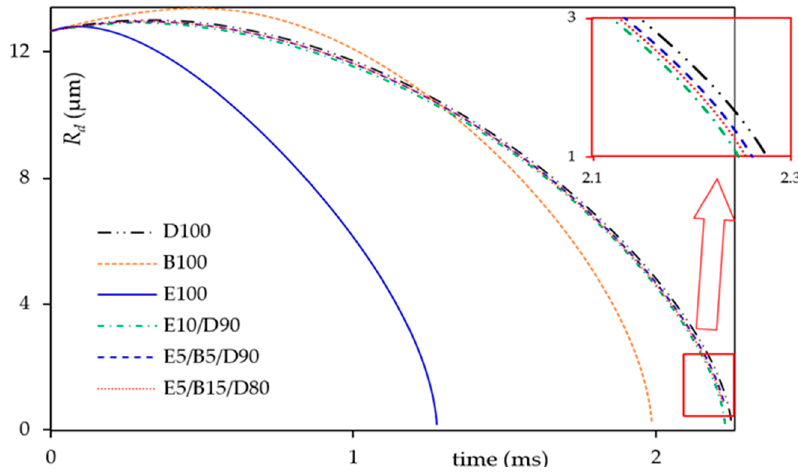
Figure 1. The evolution of droplet radii for pure diesel (indicated as D100), pure biodiesel (indicated